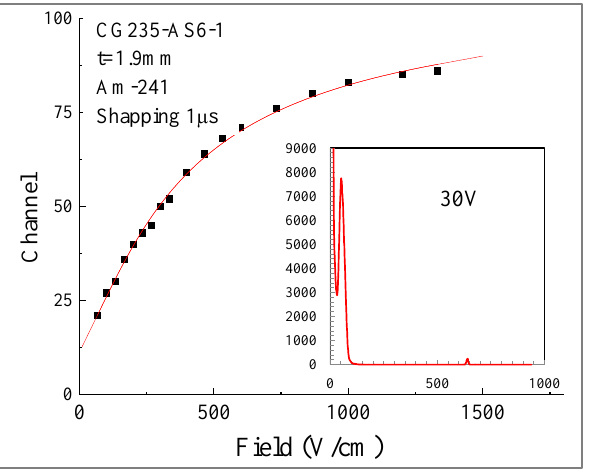
Figure 13. µτ e measurements (~2.9 × 10 −4 cm 2 /V) and gamma response to 241 Am for CRY-3.